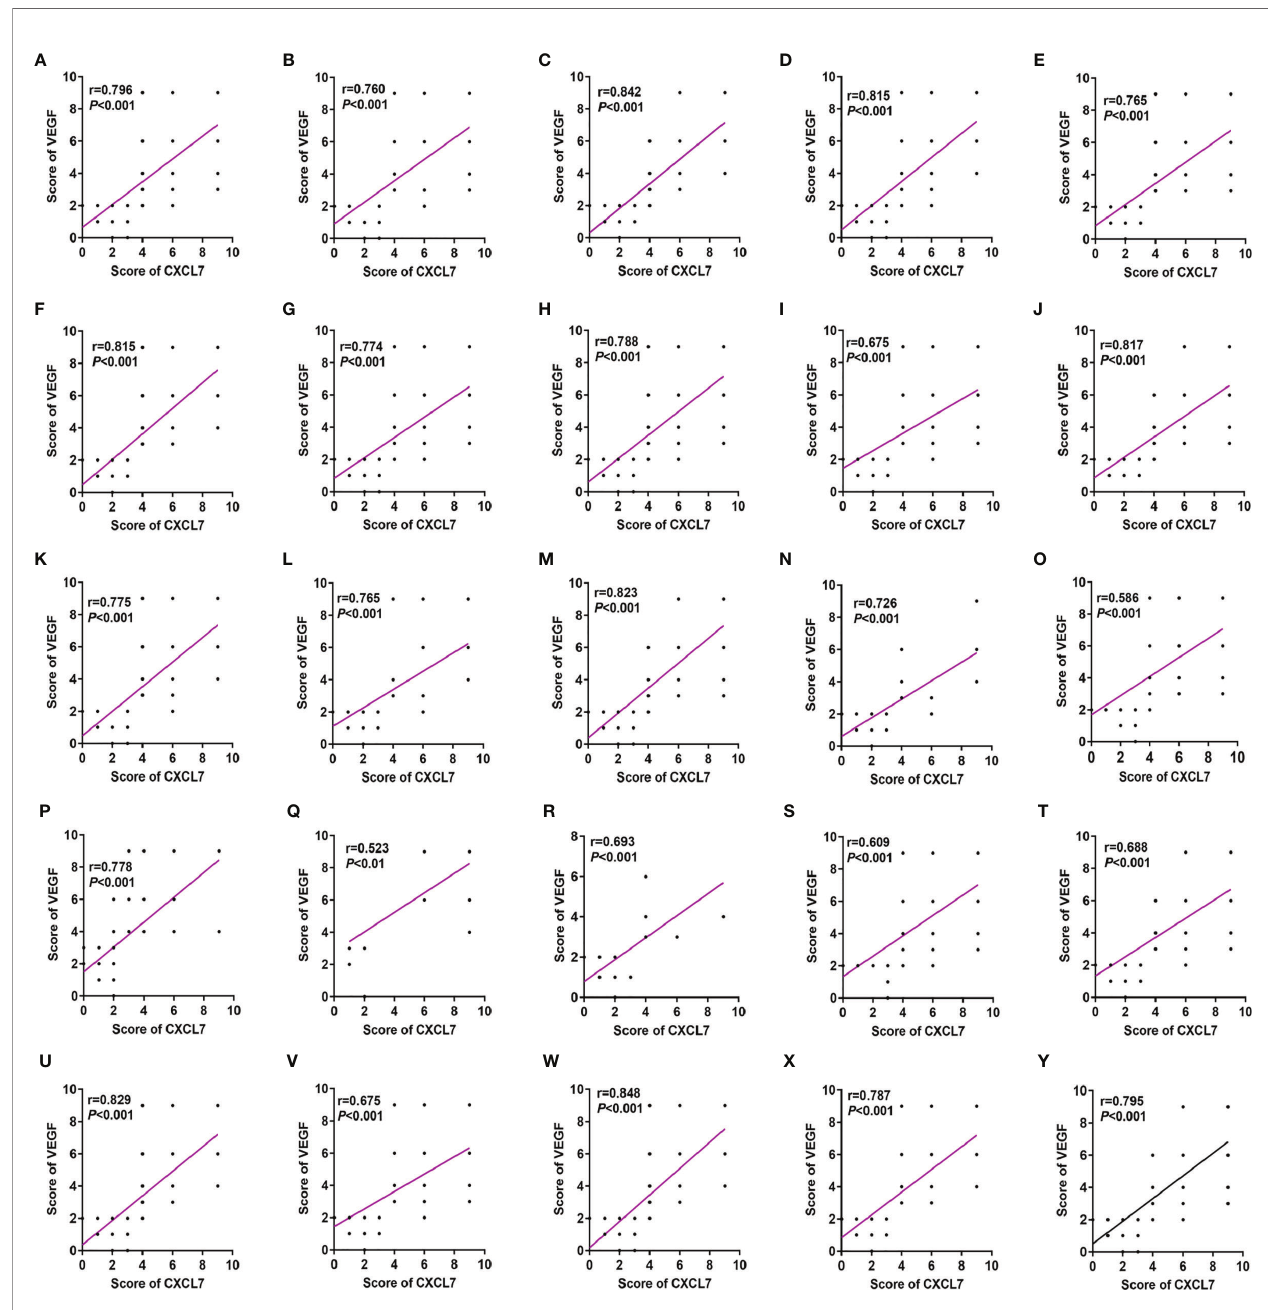
FIGURE 3 | CXCL7 positively correlated with VEGF in CRC patients grouped according to various clinical features. (A) All CRC patients. (B) Male subgroup. (C) Female subgroup. (D) Age ≤ 60 years subgroup. (E) Age > 60 years subgroup. (F) Colon subgroup. (G) Rectum subgroup. (H) Left subgroup. (I) Right subgroup. (J) Tumor size <4 cm subgroup. (K) Tumor size ≥ 4 cm subgroup. (L) T1-T2 subgroup. (M) T3-T4 subgroup. (N) N0 subgroup. (O) N1-N2 subgroup. (P) M0 subgroup. (Q) M1 subgroup. (R) I-II subgroup. (S) III-IV subgroup. (T) Non-neural invasion subgroup. (U) Neural invasion subgroup. (V) Non-vascular invasion subgroup. (W) Vascular invasion subgroup. (X) Well differentiated subgroup. (Y) Moderately-poorly differentiated subgroup. The non-parametric Spearman ’ s test was used for these